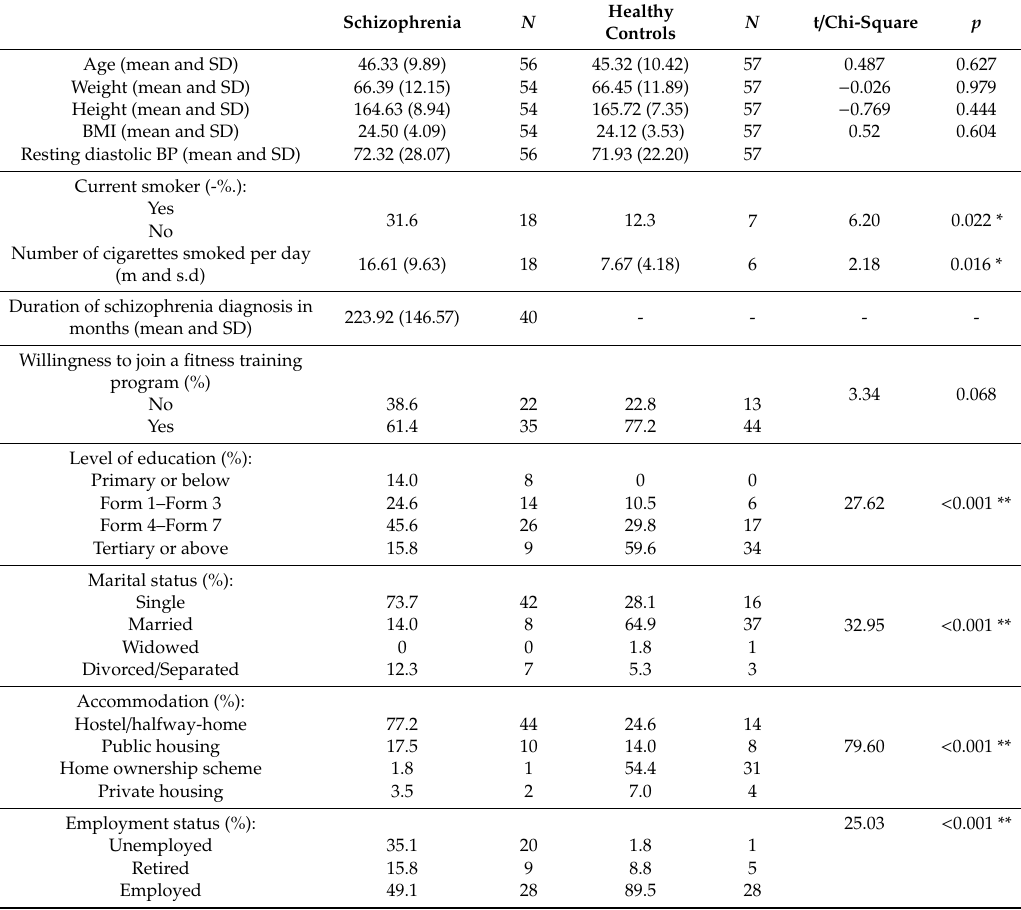
Table 1. Sociodemographic / clinical information among participants with schizophrenia vs. healthy